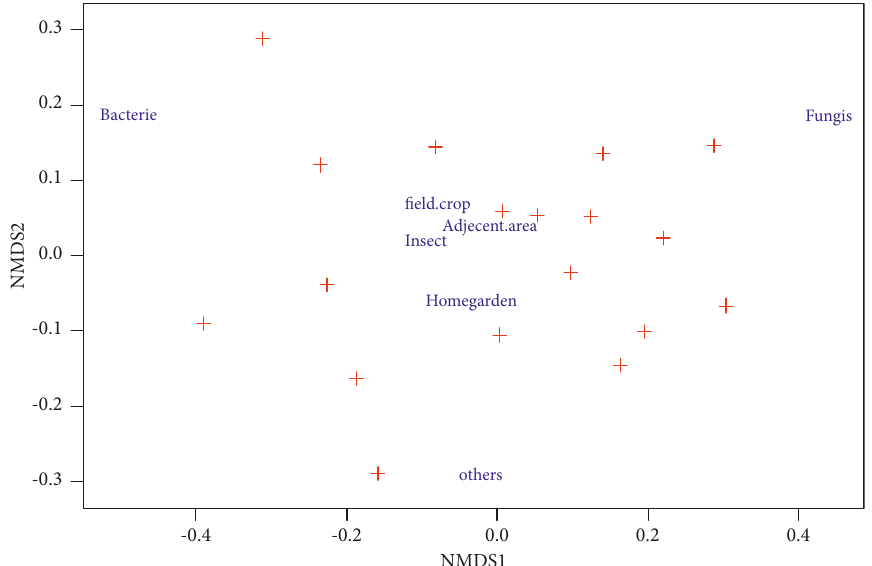
Figure 5: NMDS biplot of Bray-Curtis dissimilarity matrix (stress � 0.122) showing crop health status at the